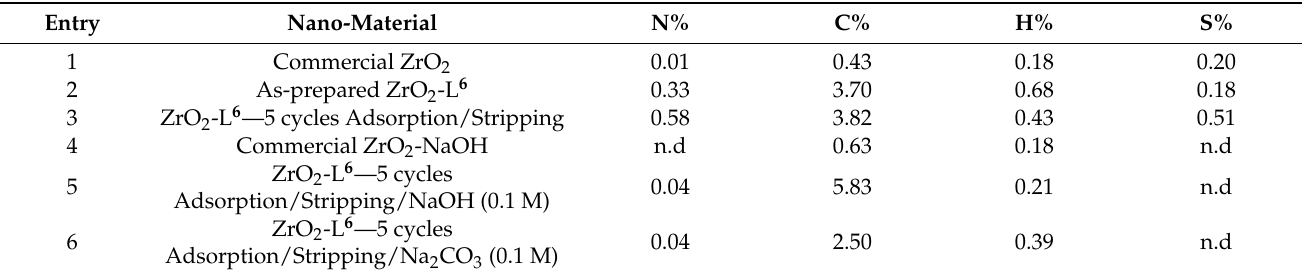
Table 6. The weight percentage of Elemental analysis (% in